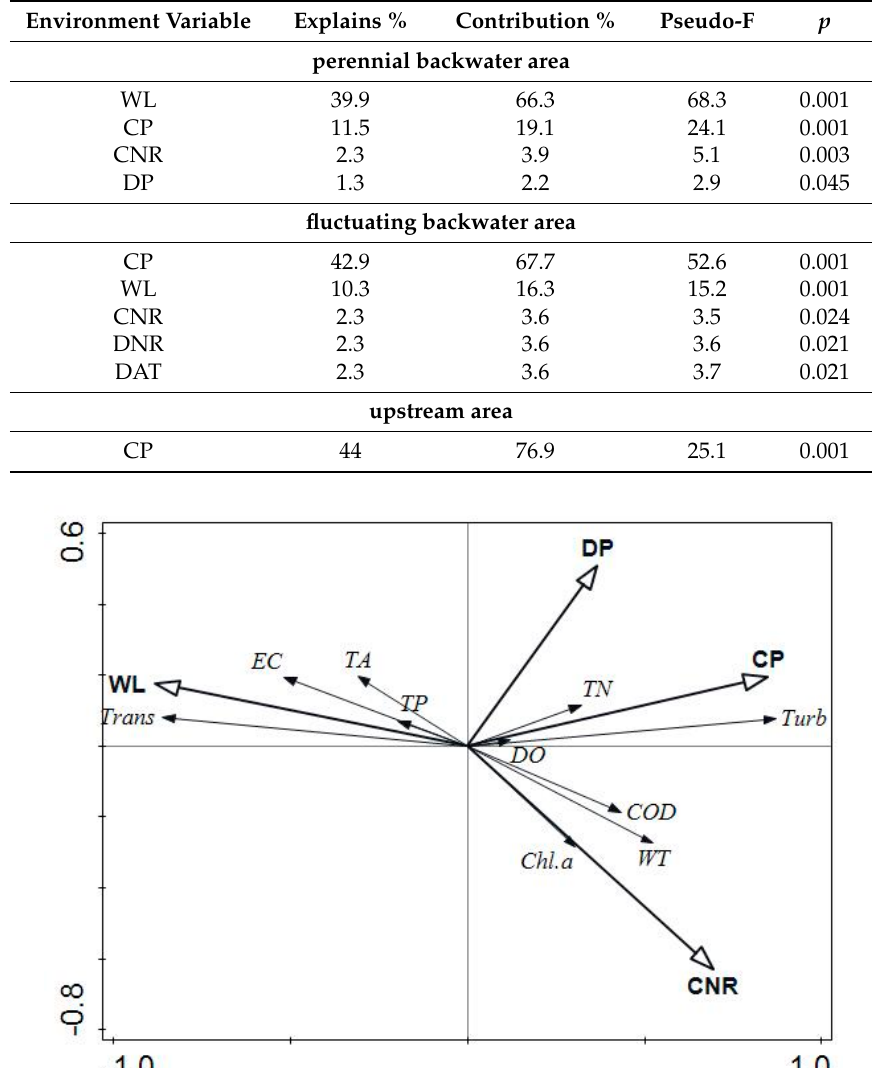
Table 3. Forward selection results of factors influencing LR water environment variables. DNR: daily net radiation; DAT: daily average temperature.